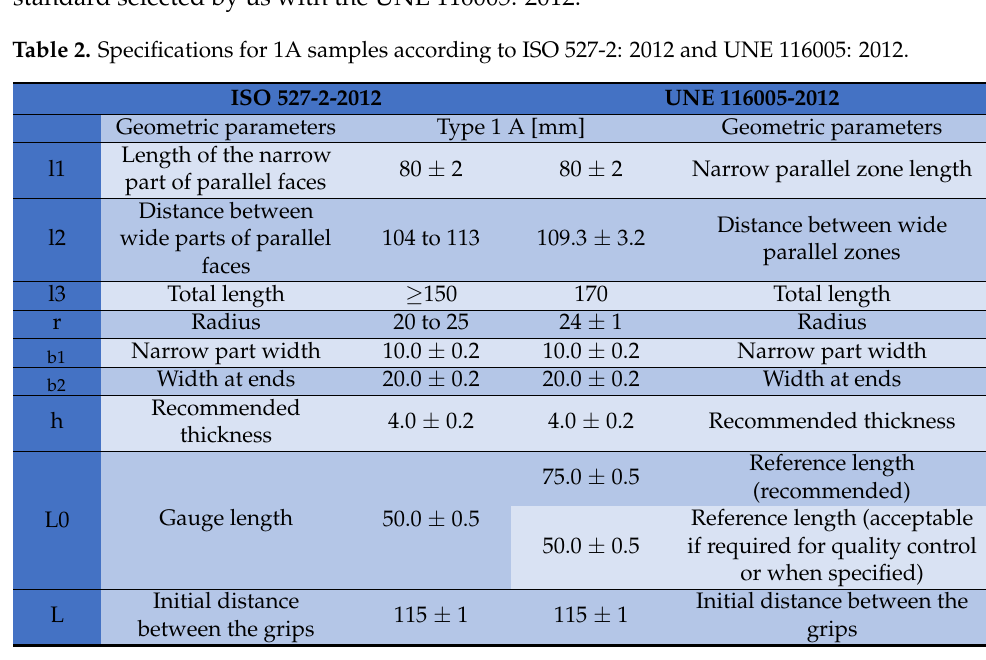
Figure 2. Tensile sample in the shape of double-sided blades.